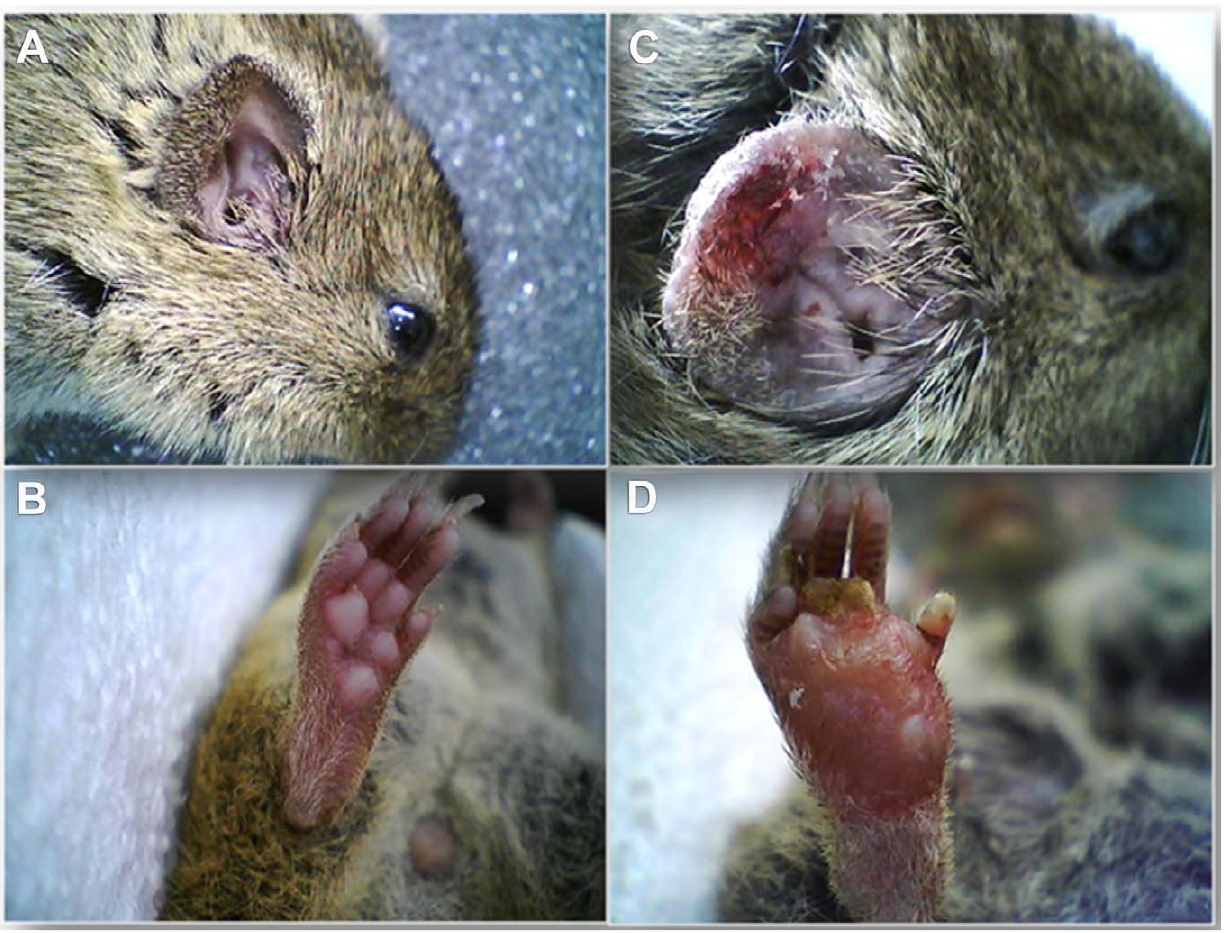
Figure 6. Pathogenesis of artificial L.major infections in voles’ ears and hind foot-pads. Before infection (A, B), and 11 weeks post- infection with 10 5 late log-phase L. major promastigotes (C, D). Infected ears (C) typically swell, depilate and ulcerate. Infected hind foot pads (D) were nodulated, ulcerated, became erythematous and edematous.